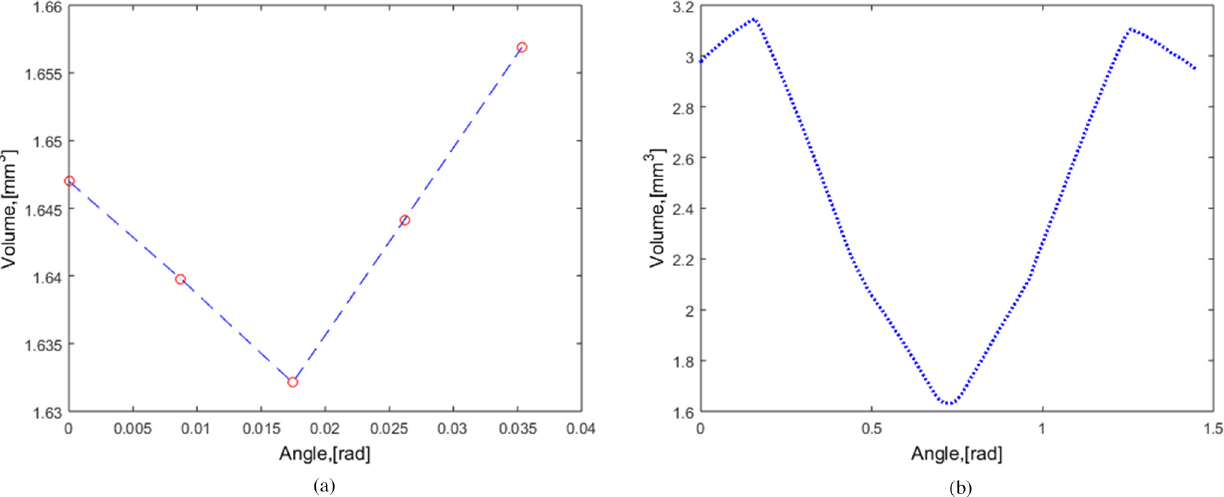
Fig. 3. The optimization functions of volume versus orientation angle between two faces (ModelC): (a) around the edge 2 on the Left side (small angle); (b) around the edge 1 on the Top side (large angle).